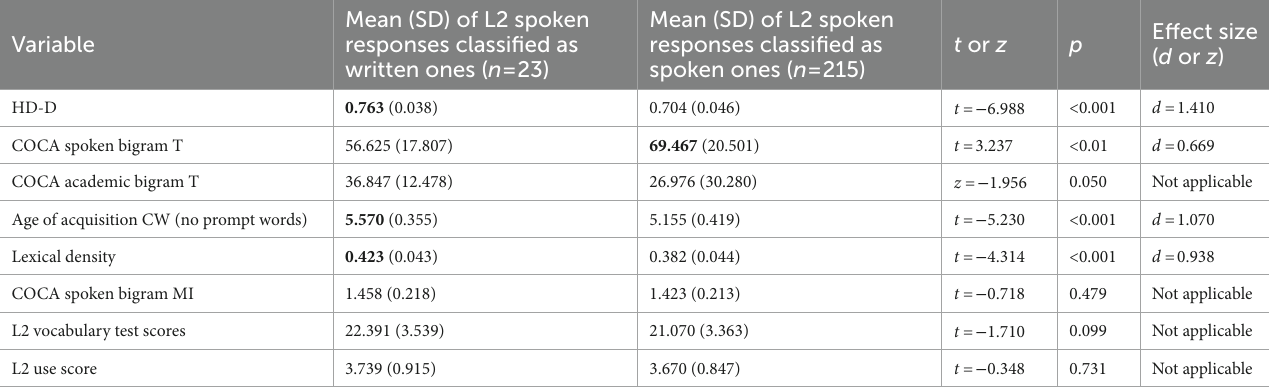
TABLE 7 t statistics for t -test results (or z statistics for Wilcoxon rank sum test results) between L2 spoken responses classified as spoken ones and those classified as spoken ones.